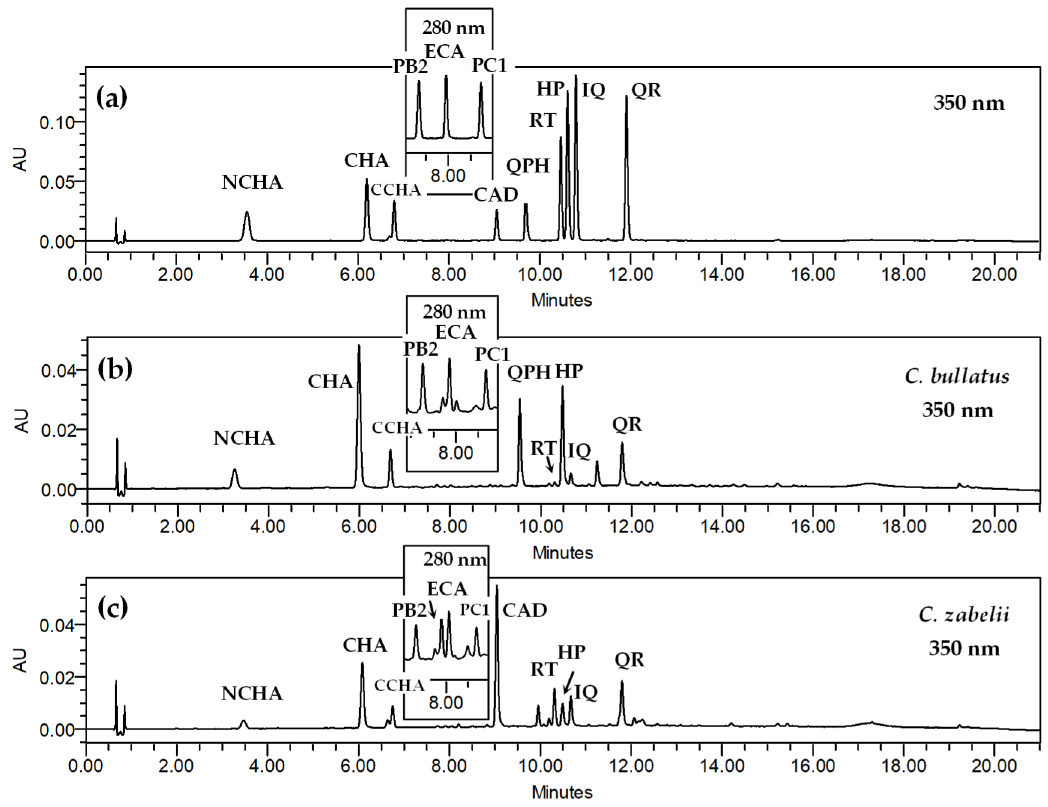
Figure 3. Representative HPLC-UV chromatograms of the phenolic standards ( a ) and the methanol–water (7:3, v / v ) extracts from the leaves of C. bullatus ( b ) and C. zabelii ( c ) at 350 and 280 nm. For compound codes, see Figure 1.